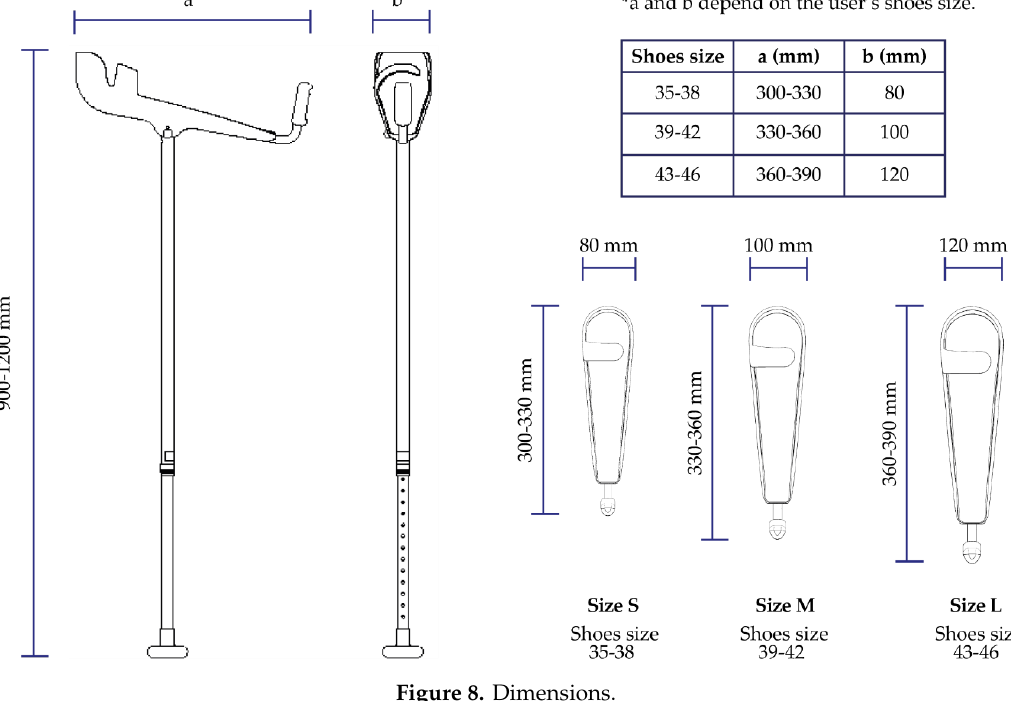
Figure 8. Figure 8. Dimensions.